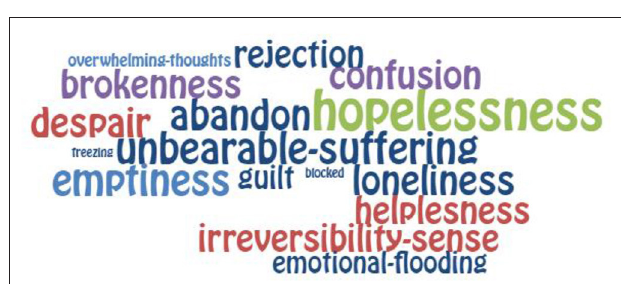
FIGURE 2 | State of suicidal mental pain: Psychological